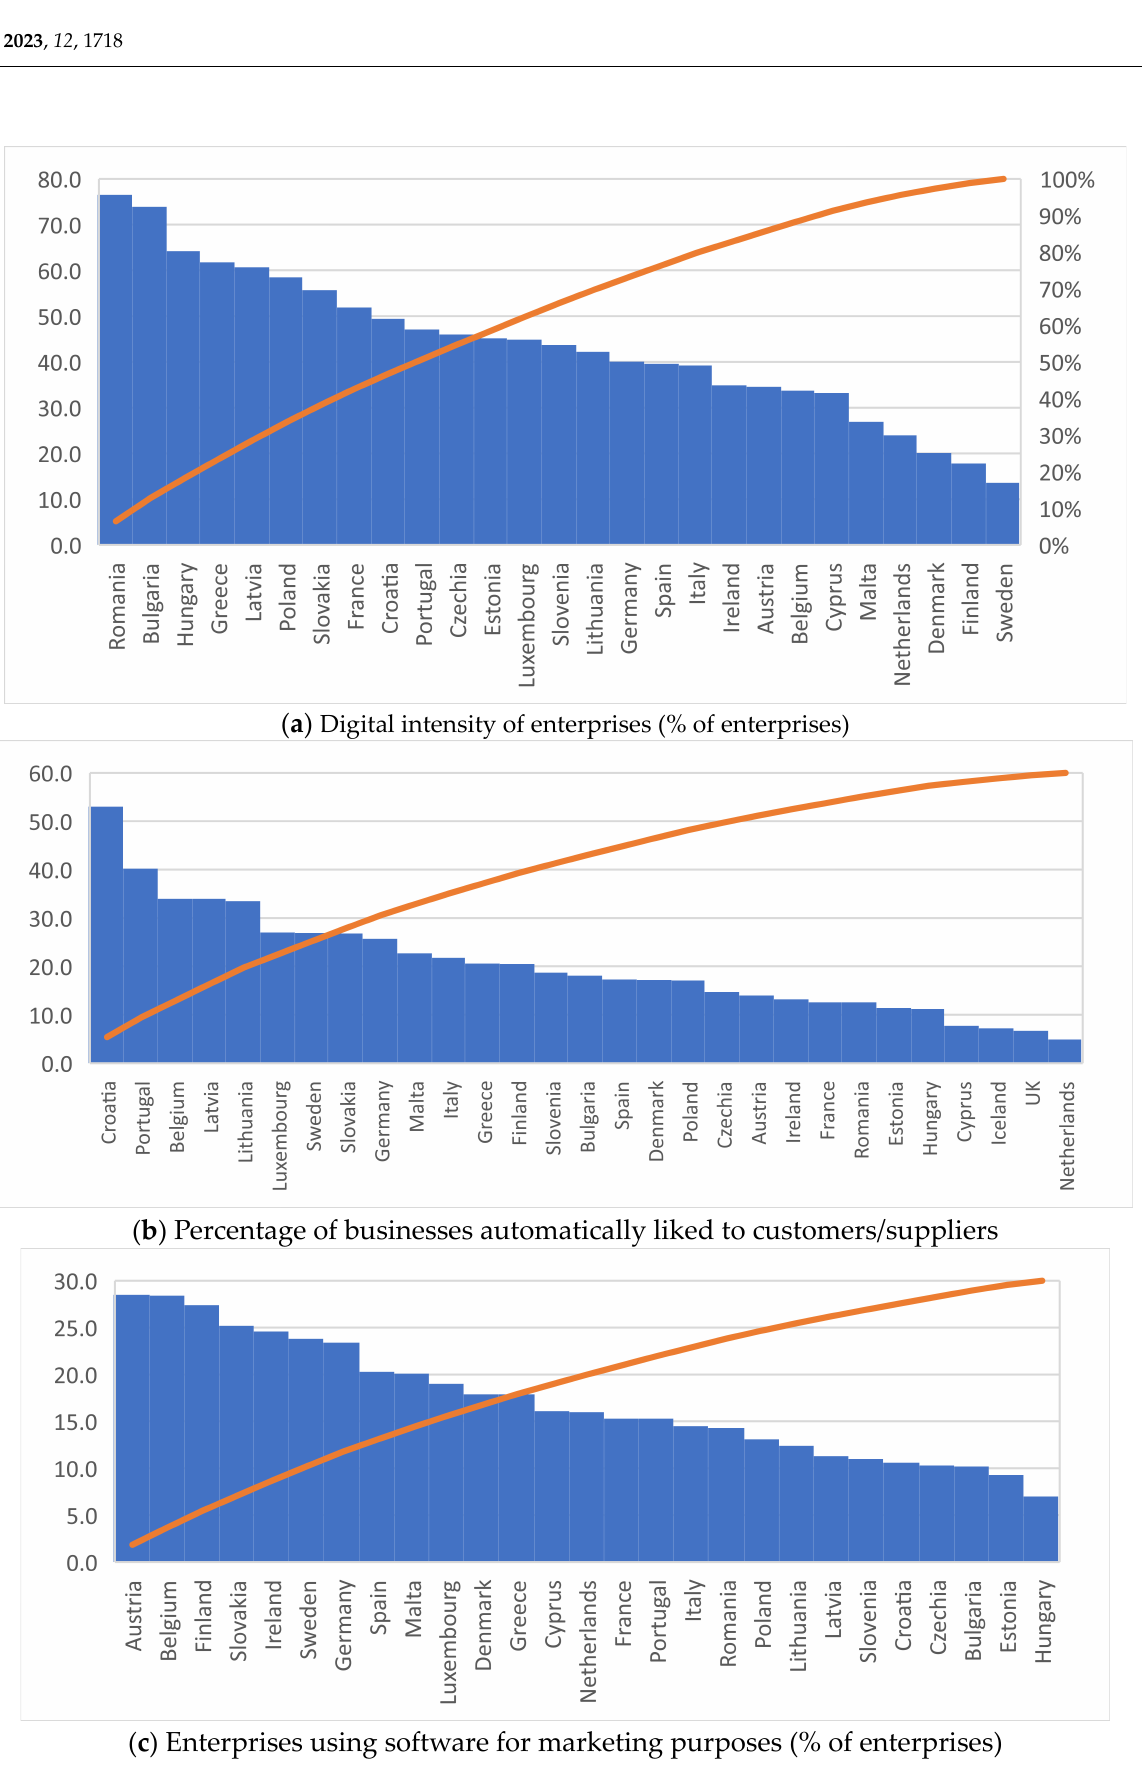
Figure 2. Selected aspects of digitalisation in businesses (source: Eurostat).